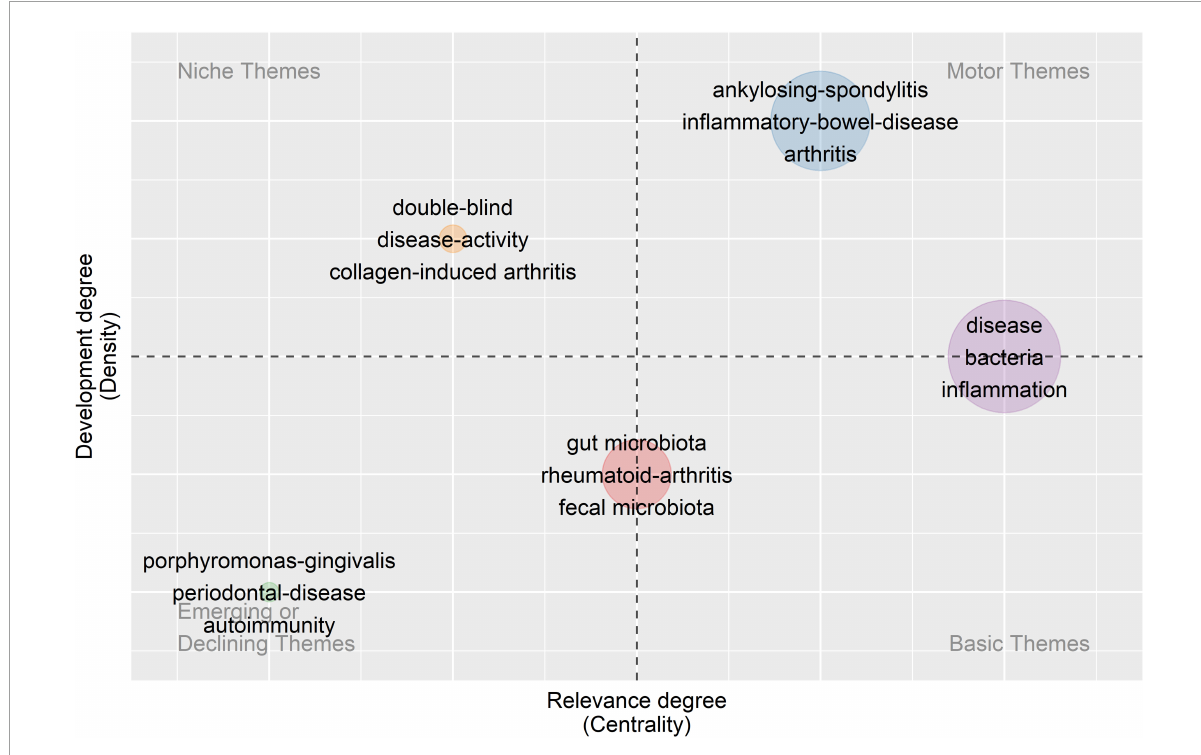
FIGURE5 Strategic diagram. Five clusters of keywords are distributed in a coordinate system according to the centrality and density of each cluster. Centrality indicates the degree of closeness of one topic with the others while density means the grade of maturity of one